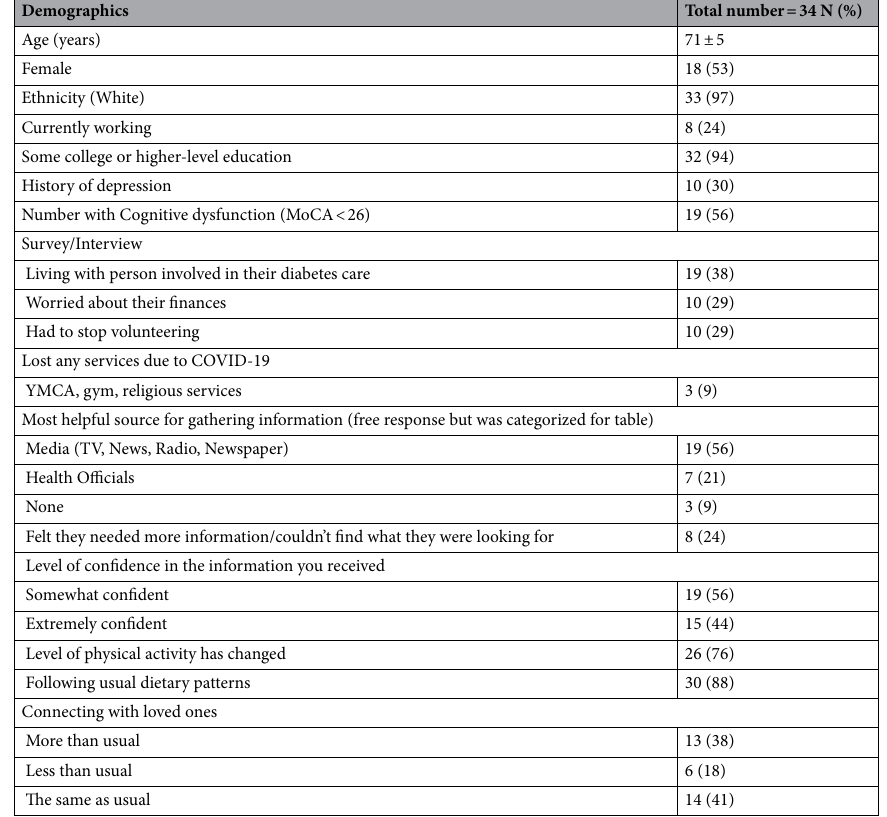
Table 1. Demographics and clinical characteristics of study